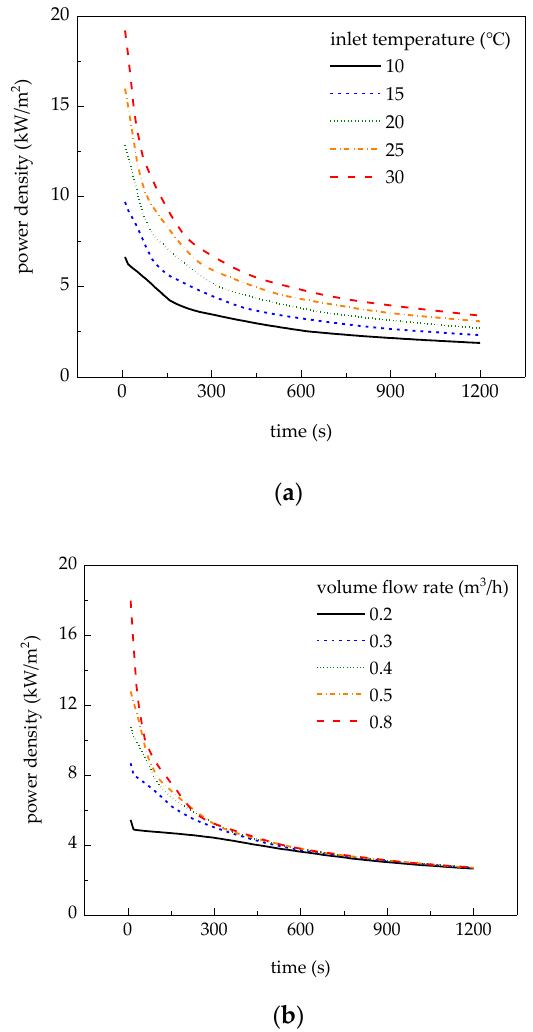
Figure 10. Effects of coolant conditions on heat exchange power density. ( a ) volume flow rate = 0.5m 3 /h. ( b ) inlet temperature = 20 °C.